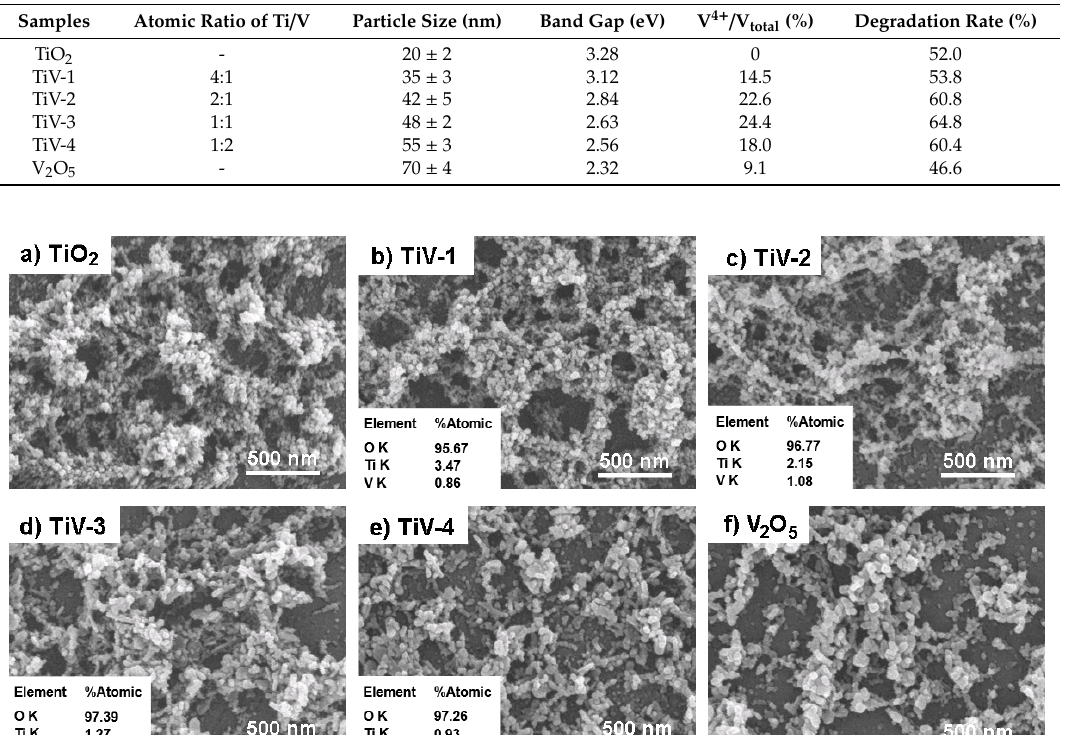
Figure 1. Surface morphologies of ( a ) TiO 2 , ( b – e ) TiV1–4, and ( f ) V 2 O 5 samples.